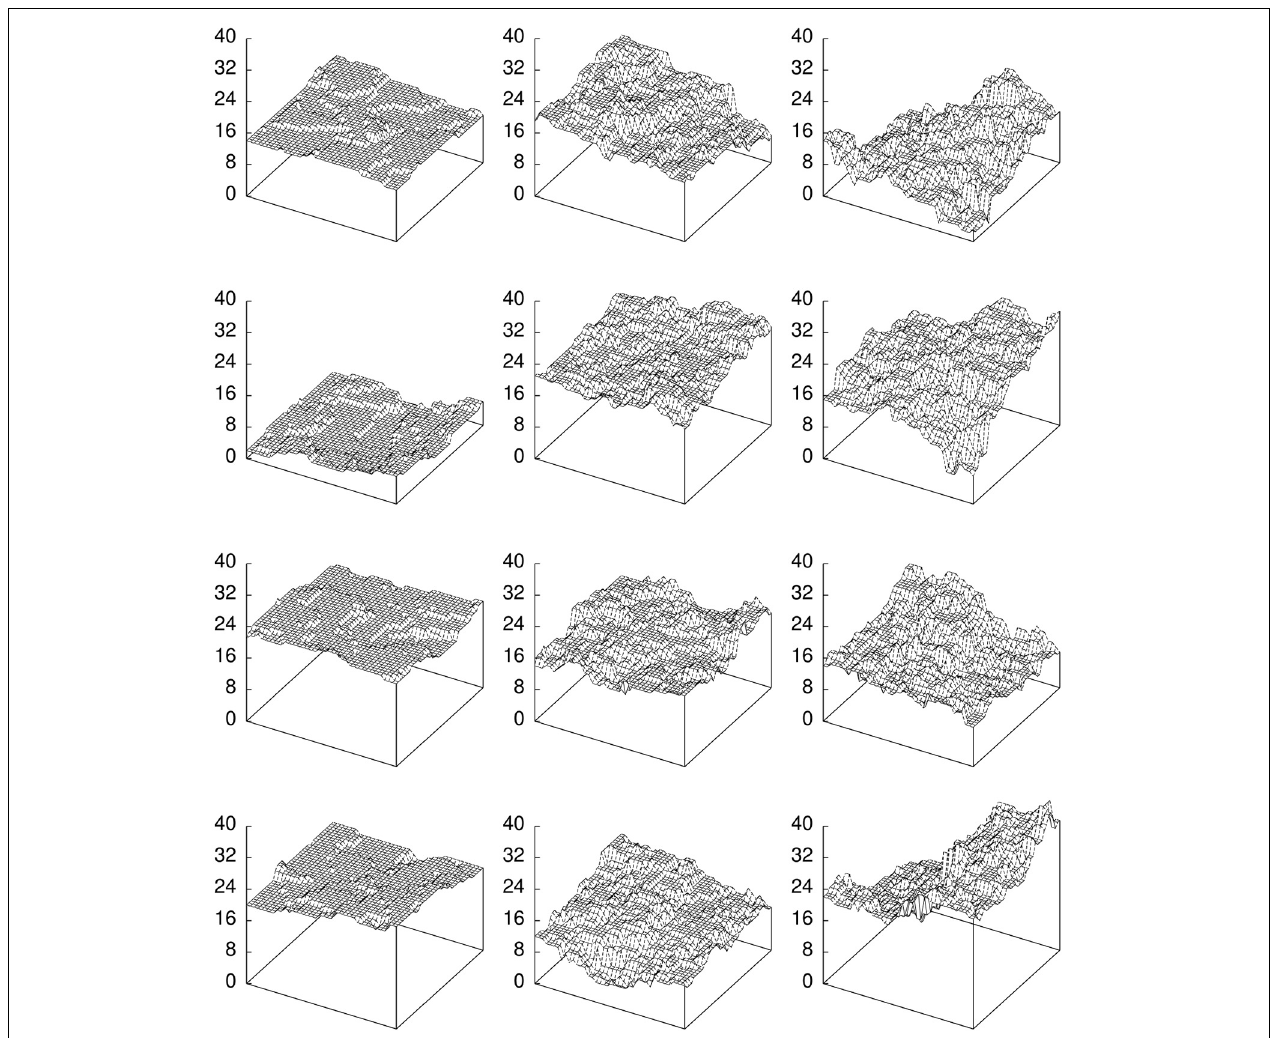
FIGURE 2 | Fracture surfaces, showing the lower remaining part of a cube lattice of size L = 40 after it has broken completely. Four samples are included for D = 1 on the left, for D = 2 at center, and for D = − 4 on the